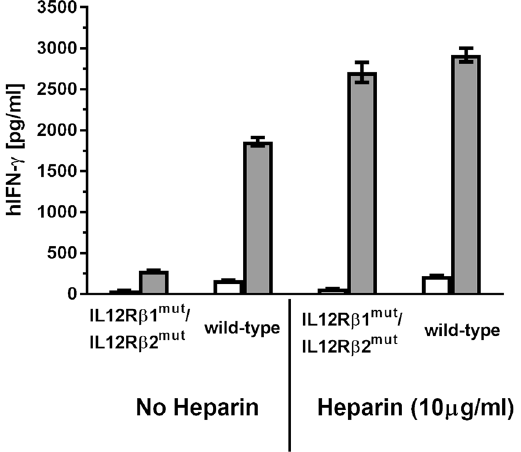
Figure 5. Heparin-induced recovery of hIL-12 activity. hIFN- γ production by parental NK-92MI cells and IL-12R β 1 mut /IL-12R β 2 mut NK-92MI cells treated with 0 ng/ml hIL-12 (white bars) or 200 ng/ml hIL-12 (gray bars) in the presence and absence of 10 ng/ml heparin was quantified via ELISA. All data are represented as mean ± standard deviation from triplicate